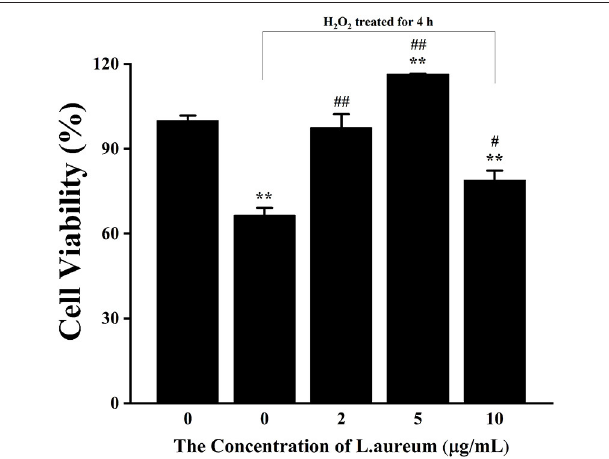
FIGURE 3 | The effect of L. aureum on the viability of RAW264.7 cells under oxidative stress. Cells were treated with different concentrations of L. aureum (0, 2, 5, 10 µ g/ml) for 20h. The positive control group and L. aureum treated groups were then exposed to H 2 O 2 (400 µ M) for 4h. The results were expressed as the mean ± SD of three independent experiments. ** p < 0.01 compared with blank control group, # p < 0.05 and ## p < 0.01 compared with positive control group were considered statistically significant